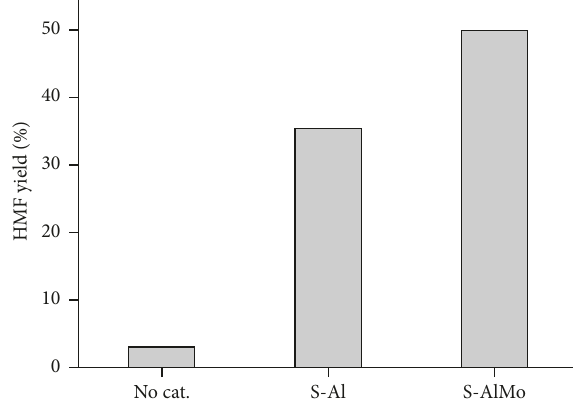
Figure 1: Effect of the type of catalysts on fructose dehydration to HMF. Conditions: fructose (50 mg), catalyst (20 mg), DMSO